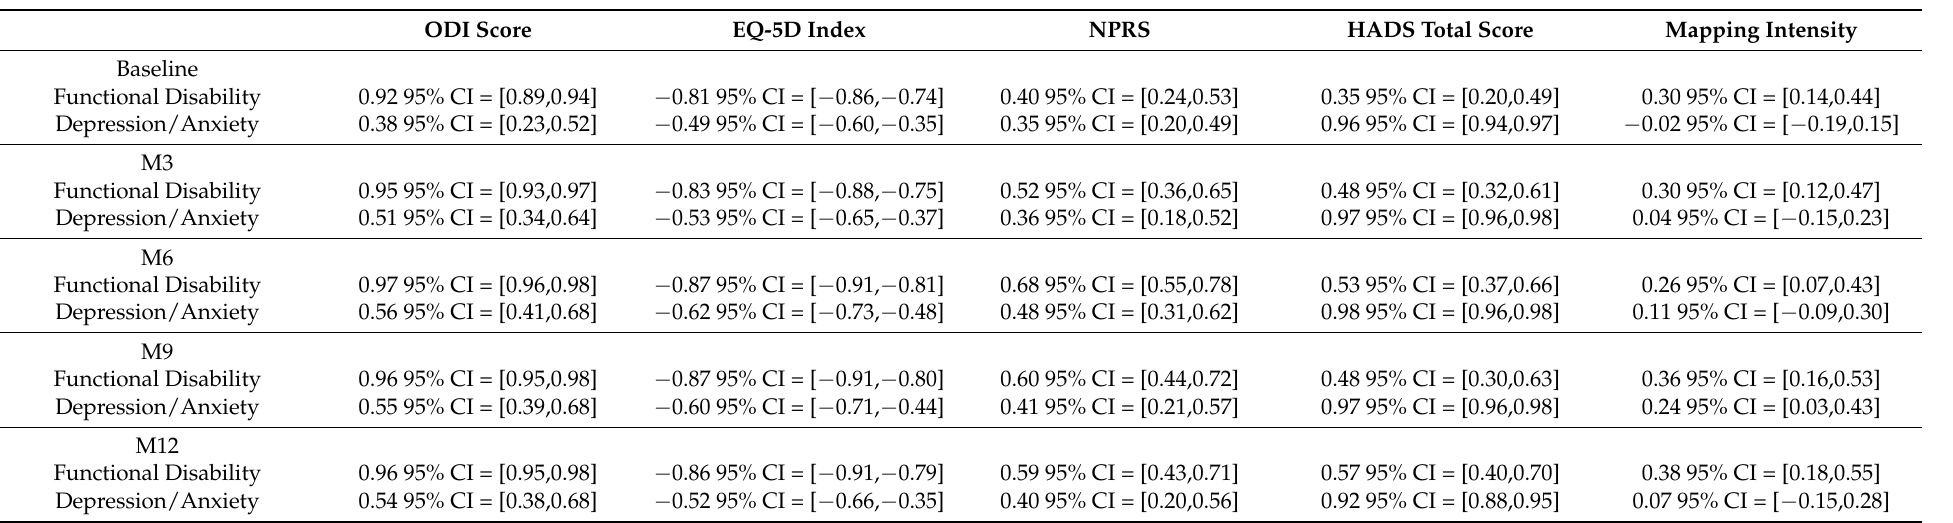
Table 4. Correlations at baseline between the scores obtained from EFA and the standard pain evaluation